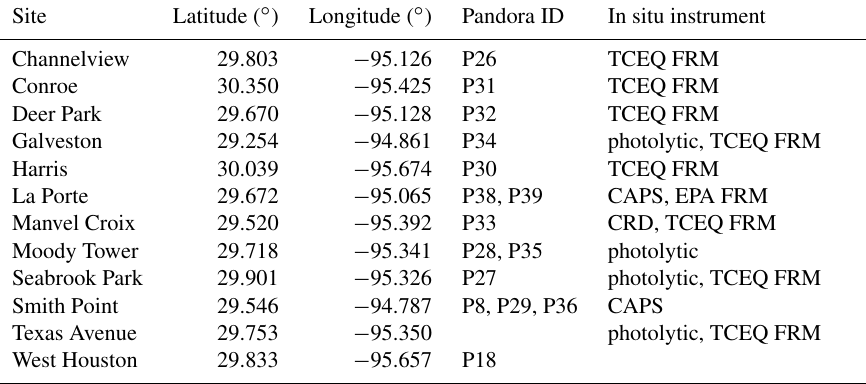
Table 3. DISCOVER-AQ sites used in GeoTASO validation and site instrumentation. The Pandora ID is an identification number given to each individual Pandora instrument.